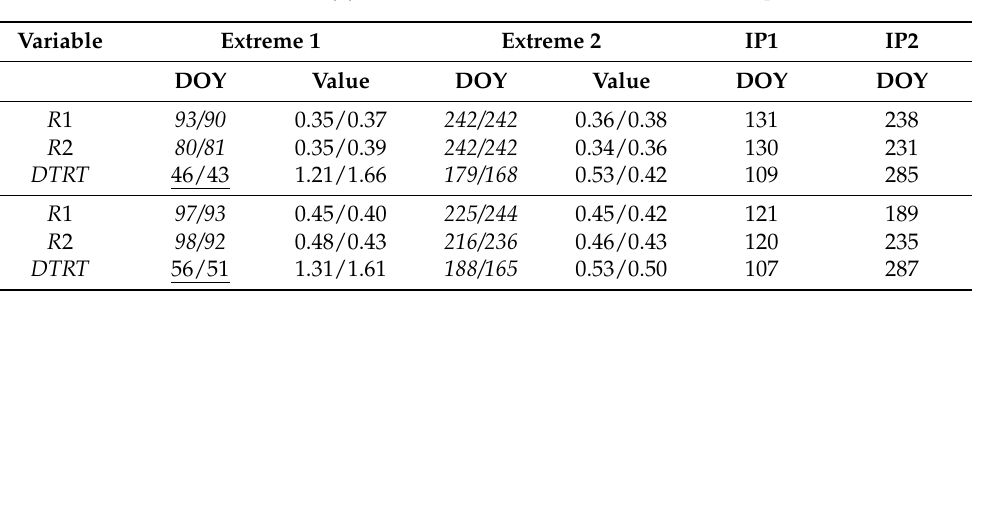
Table 5. Timing of extreme values and inflection points of R 1, R 2 and DTRT at RS climate station for different observational periods (note the denotations used in all the following tables: (a) fitted value/measurement-based value; (b) italic—minimum;